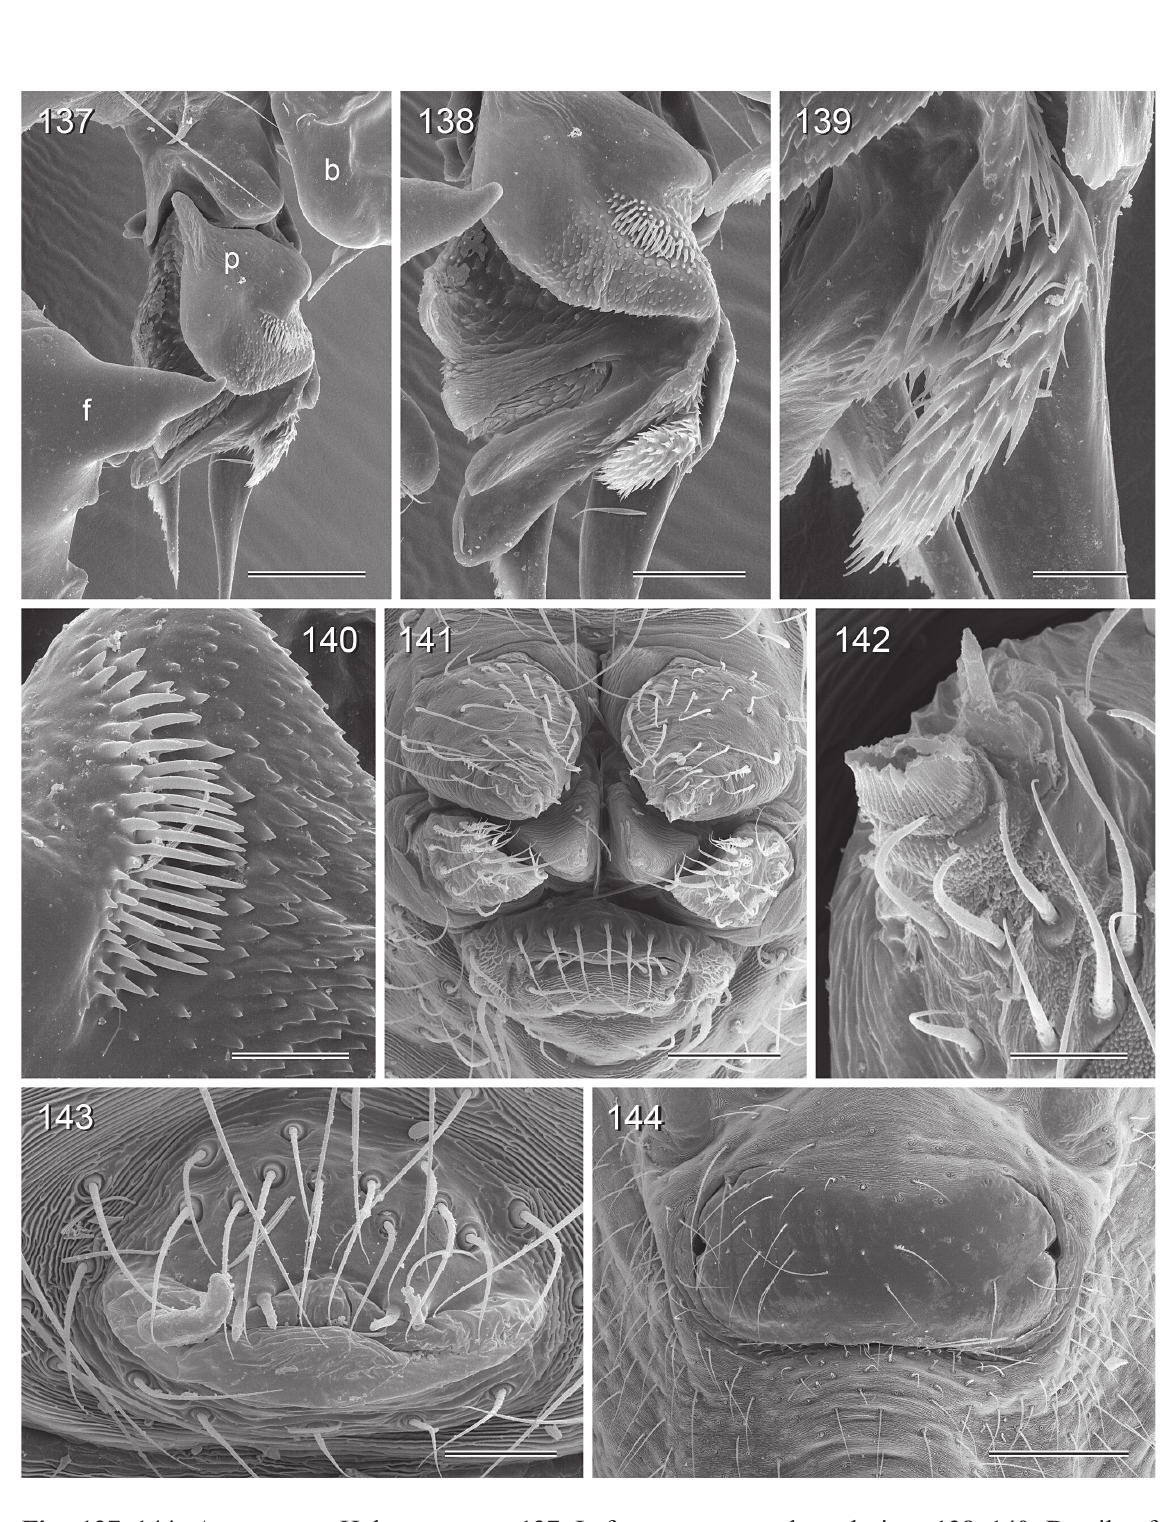
Figs 137–144. Aetana gaya Huber, sp. nov. 137 . Left procursus, prolateral view. 138–140 . Details of preceding. 141 . Male spinnerets. 142 . Male ALS. 143 . Male gonopore. 144 . Epigynum. b = genital bulb; f = femur; p = procursus. Scale lines: 137 = 100 µm; 138, 141 = 60 µm; 139–140 = 20 µm; 142 = 10 µm; 143 = 30 µm; 144 = 200